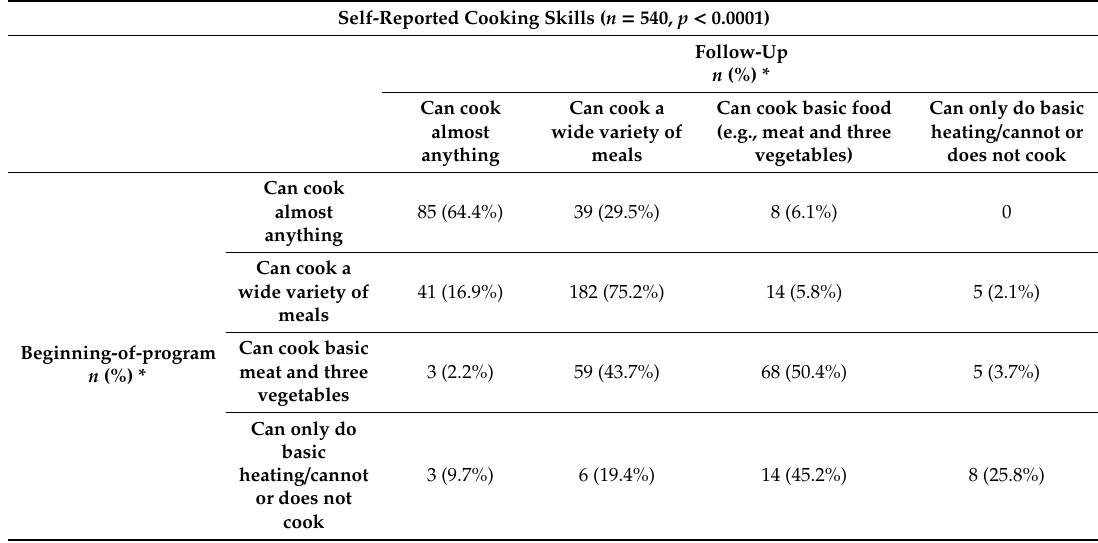
Table 3. Self-reported cooking skills comparison between the program’s beginning and follow-up questionnaires.